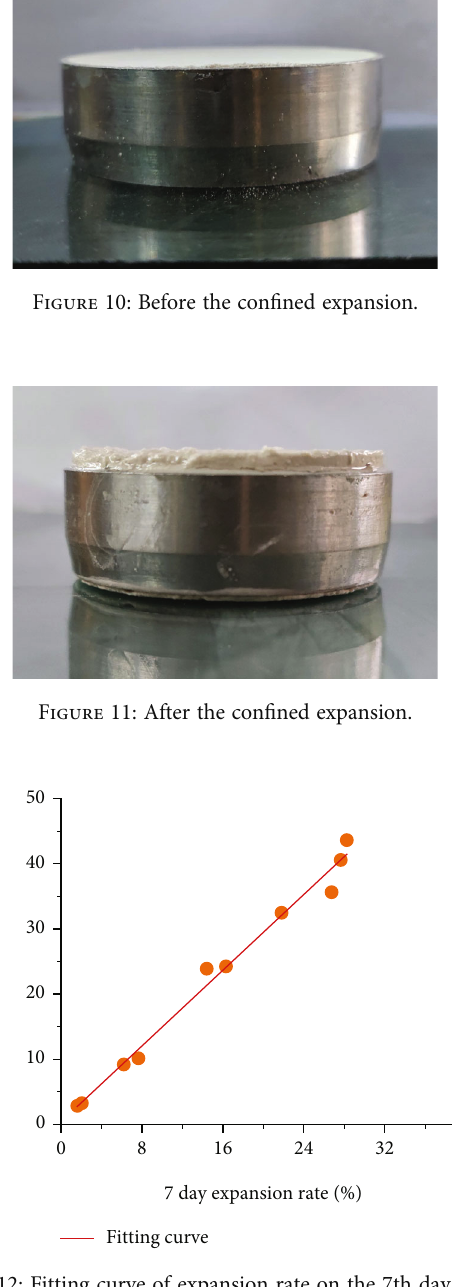
Figure 12: Fitting curve of expansion rate on the 7th day and the 30th day.